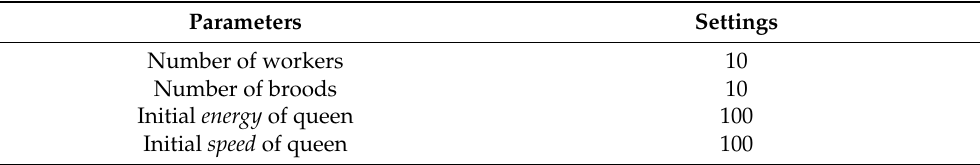
Table 5. Parameters of the MBO